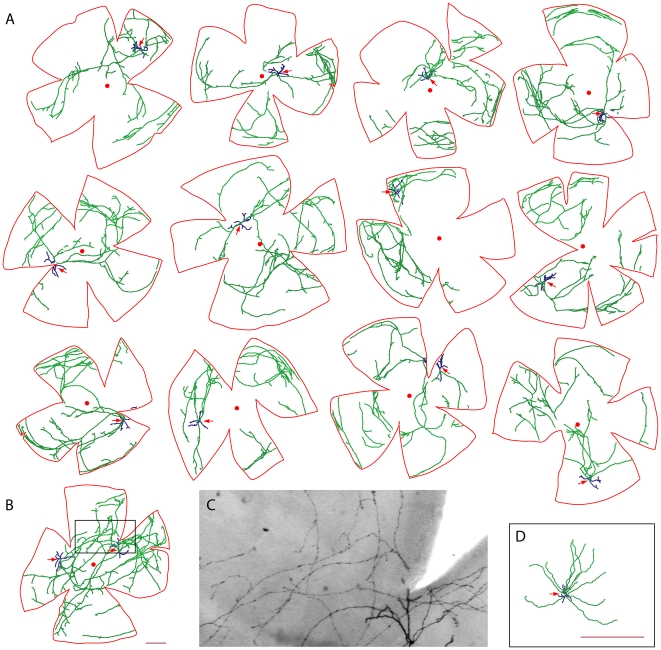
Morphologies of individual AP+ type 1 DA cells from the retinas of TH-IRES-CreER;R26IAP mice.A single 100–300 µg 4HT injection was administered IP between P3 and P8; retinas were analyzed ∼6 weeks later. Retina flat mounts were processed for AP histochemistry and clarified in BBBA. Axon-like processes (green) and dendrites (blue) were traced with Neuromantic software. The soma is indicated by a red arrow. The outline of the flattened retina and the location of the optic disc are shown in red. (A) Twelve retinas, each of which had a single type 1 DA cell. (B) A retina with two type 1 DA cells. (C) Image of the boxed region of the retina shown in (B). The dendrites (lower right) are uniformly thicker and more darkly stained than the axon-like processes. (D) A putative type 2 DA cell. Scale bars in B and D, 500 µm. Scale bar in B applies to panels A and B. BBBA causes ∼30% tissue shrinkage.